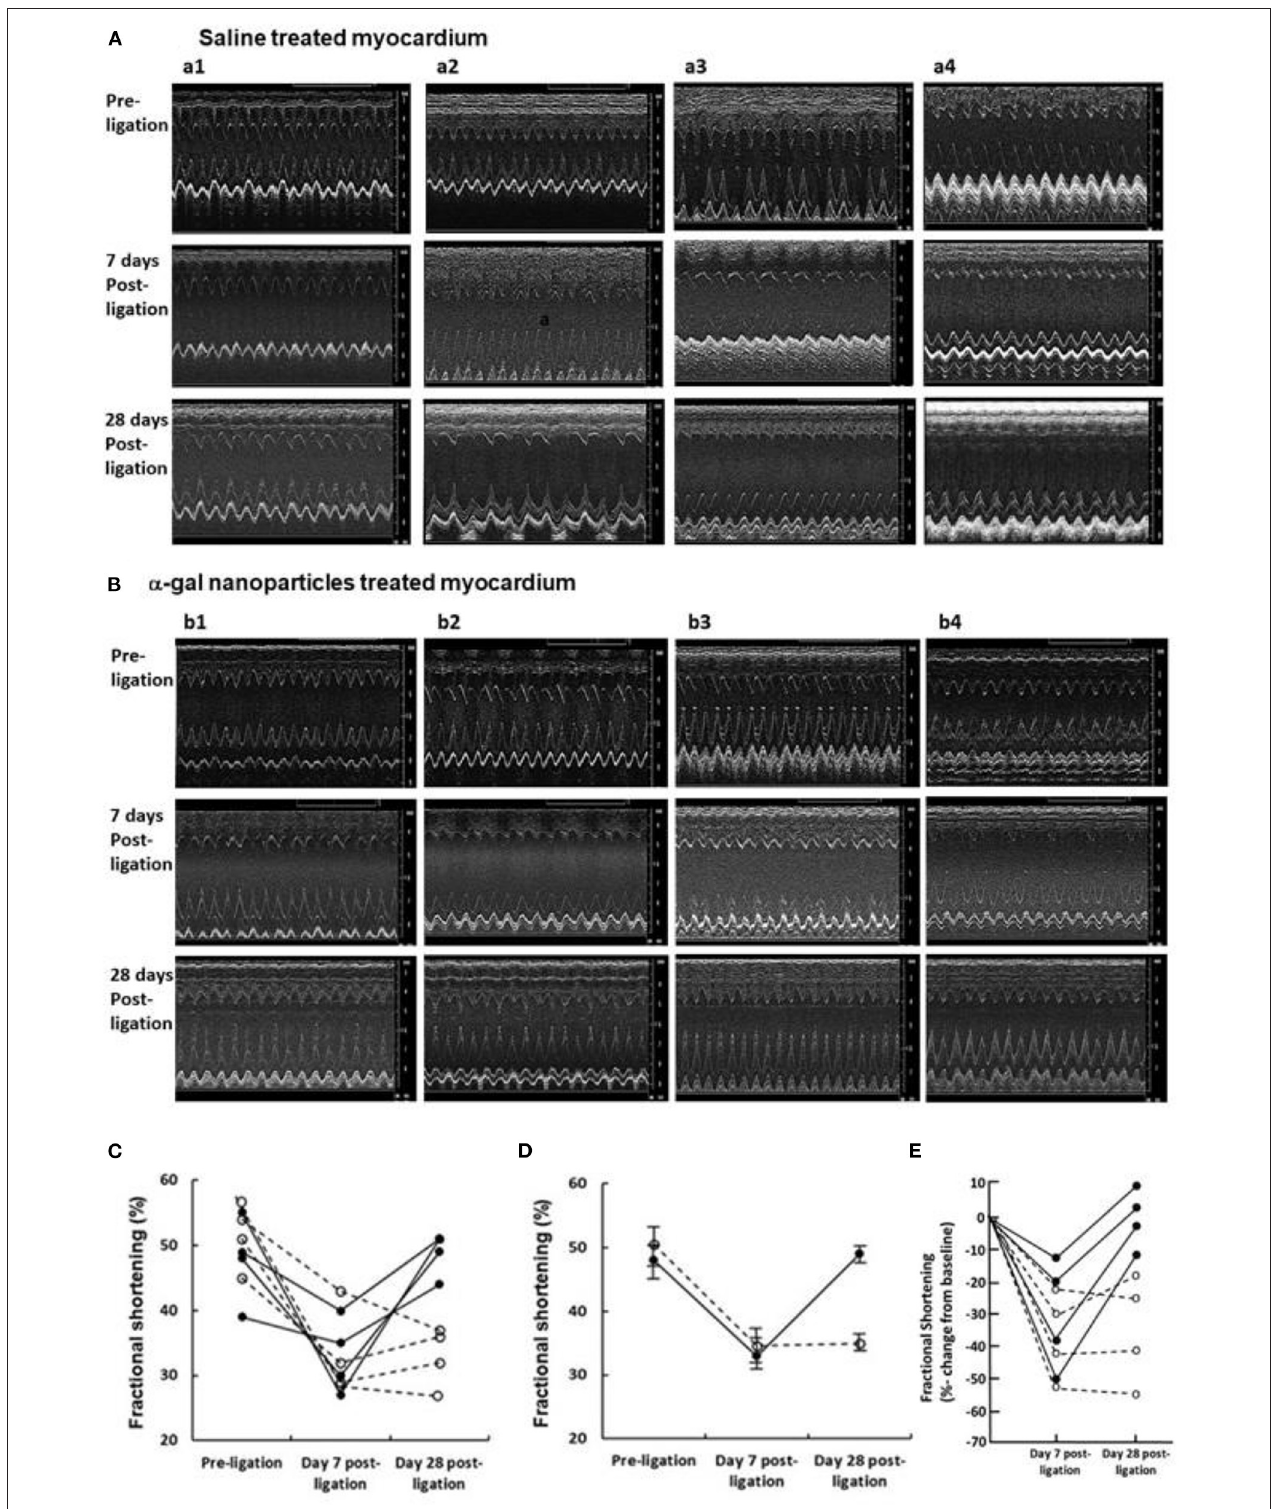
FIGURE 4 | Echocardiography of (A) 4 saline controls (a1–4), and (B) 4 α -gal nanoparticles treated mice (b1–4), pre-LAD ligation, 7- and 28-days post-ligation. (C) Fractional-shortening (FS) at each 3 time points. Dashed-lines and open-circles represent control mice (a1–4), solid-lines and closed-circles represent treated mice (b1–4). (D) Mean ± SE at each time points. FS data for the two groups are significantly different only on Day 28. Statistical analysis was performed by Student t -test, p < 0.001. (E) Data presented as percentage changes from baseline in Fractional Shortening at 7- and 28-days post-ligation. Symbols and lines are as in (C) .